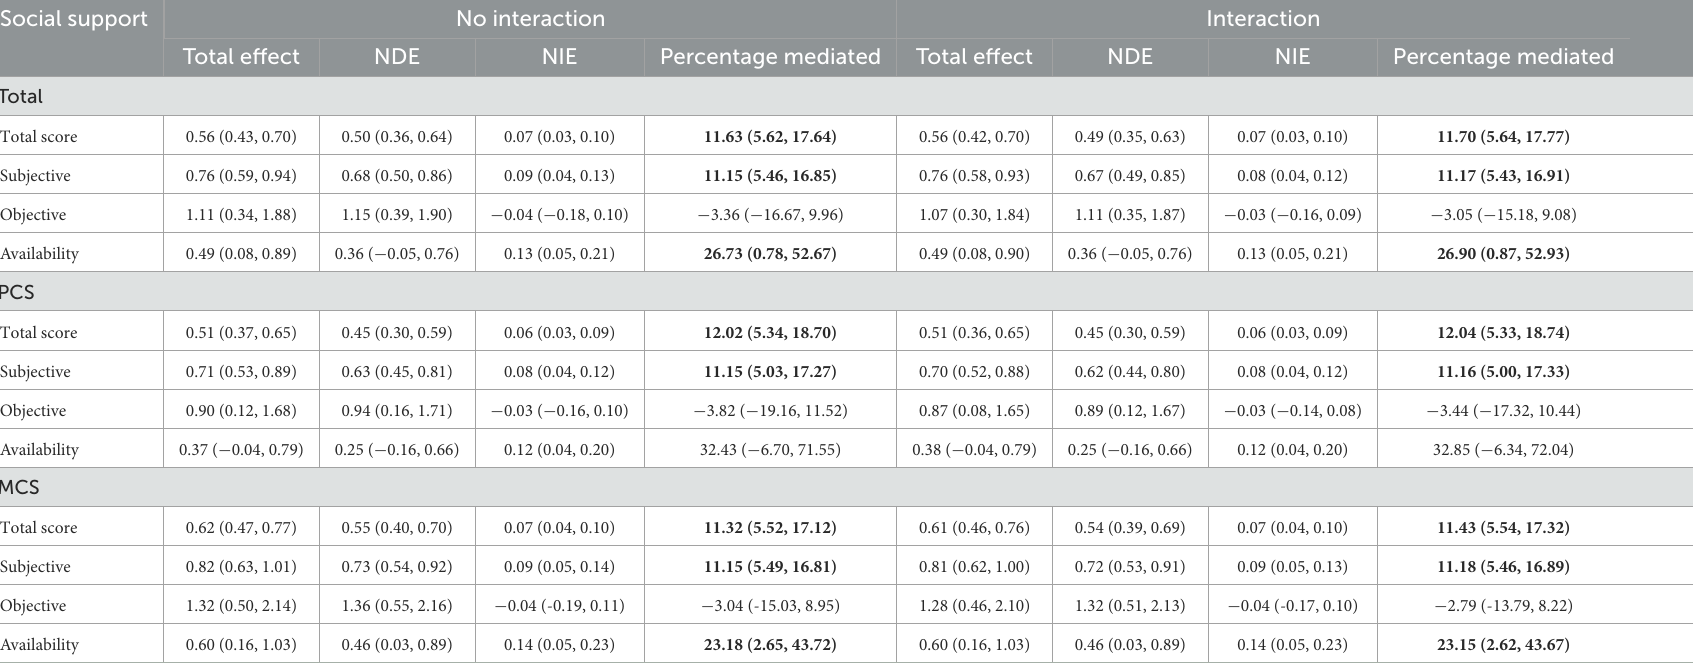
TABLE 4 Proportion of association of social support with quality of life mediated by healthy lifestyle among migrant